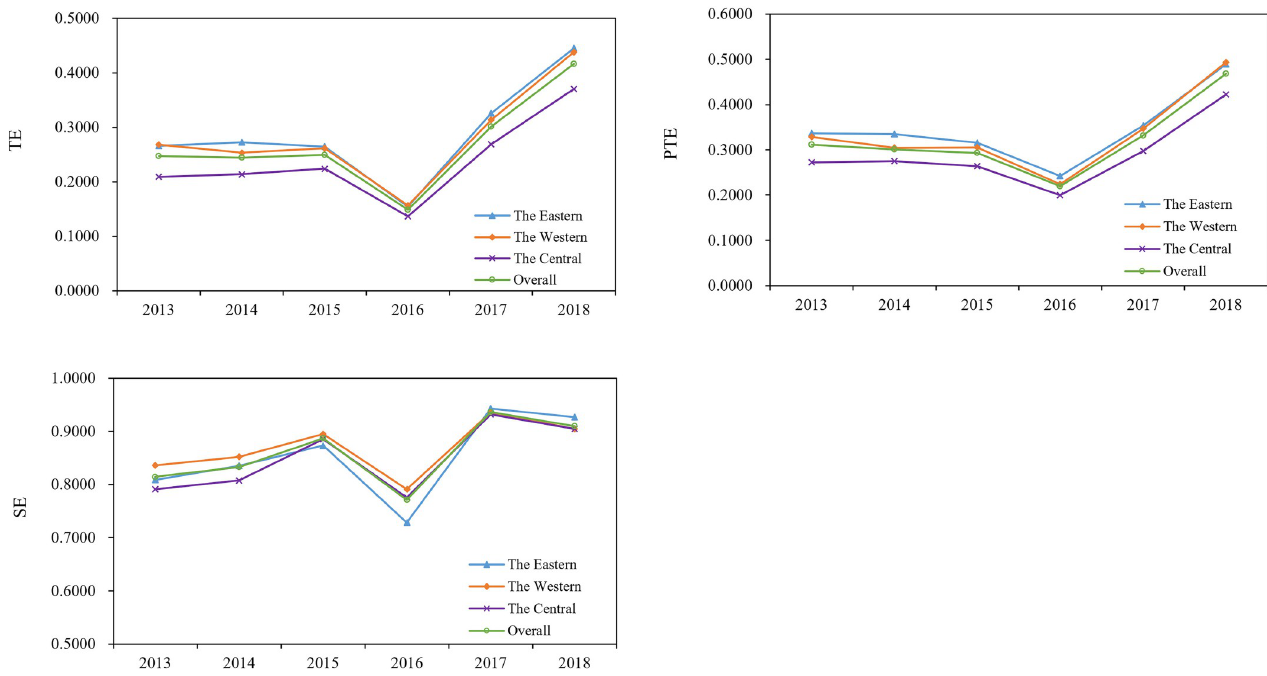
Fig 3. Hospital efficiency in the Eastern, Western and Central regions from 2013 to